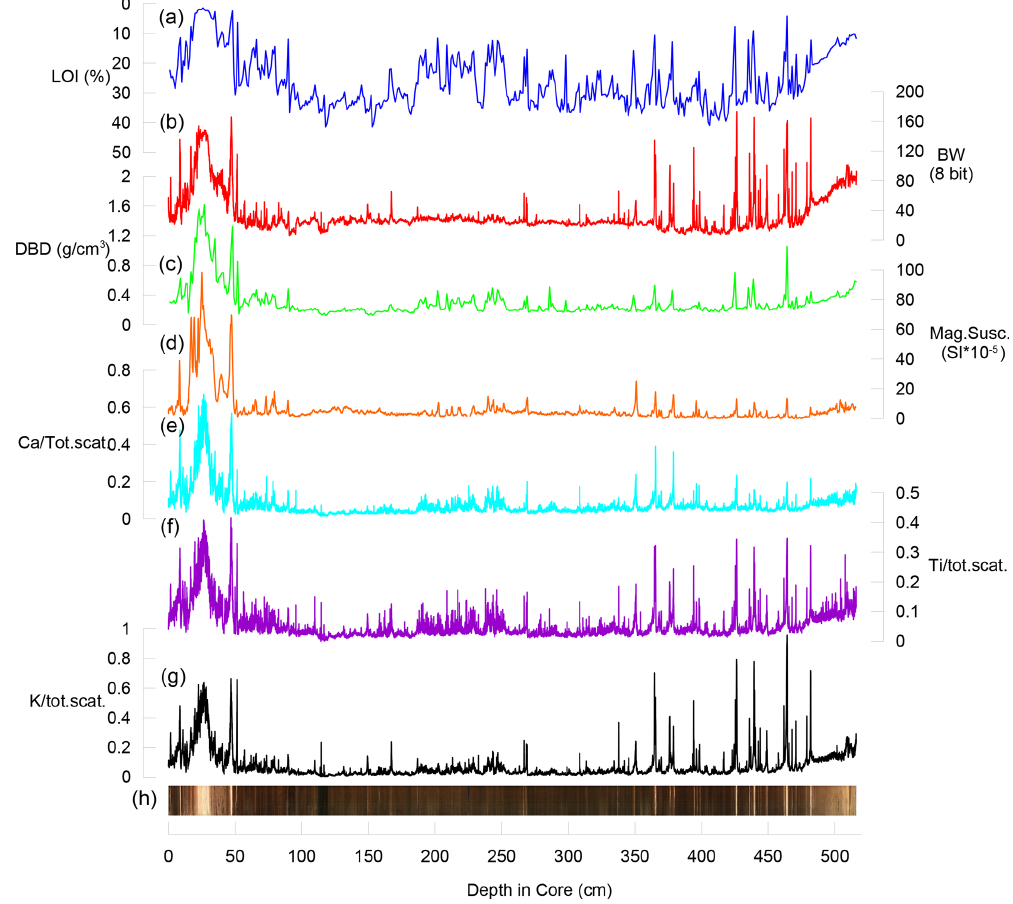
Figure 9. Results from measured parameters in FLP213. (a) Loss on ignition (LOI, %) indicated content of organic matter in the core and is plotted on an inverse scale (blue). (b) BW (red) shows the 8 bit (0–255) black–white values extracted from a photo of the core surface where 0 is black. (c) Dry bulk density (DBD) is plotted in unit gcm − 3 (green). (d) Magnetic susceptibility (orange) is plotted as SI × 10 − 5 as magnetic susceptibility is a dimensionless parameter. (e–g) XRF data (K, Ca, and Ti) are normalized against total scatter to reduce the potential effect of water content. (h) RGB photo of core. Table 3. Correlation between measured parameters in FLP213 (in bold) and FLS113 (in italic). LOI, BW, DBD, MS, and the XRF data (K, Ca, and Ti) were measured in FLP213, whereas CT greyscale, MS, and the XRF data (K, Ca, and Ti) were measured in FLP113. LOI (%) indicates content of organic matter in the core; BW is the 8-bit (0–255) black–white values extracted from a photo of the core surface where 0 is black. CT greyscale is a 16-bit number indicating relative densities of the core; DBD is given in unit gcm − 3 (green). MS is measured as SI × 10 − 5 (it is a dimensionless parameter). XRF data (K, Ca, and Ti) are normalized against total scatter to reduce the effect of water content. All correlations are significantly different from